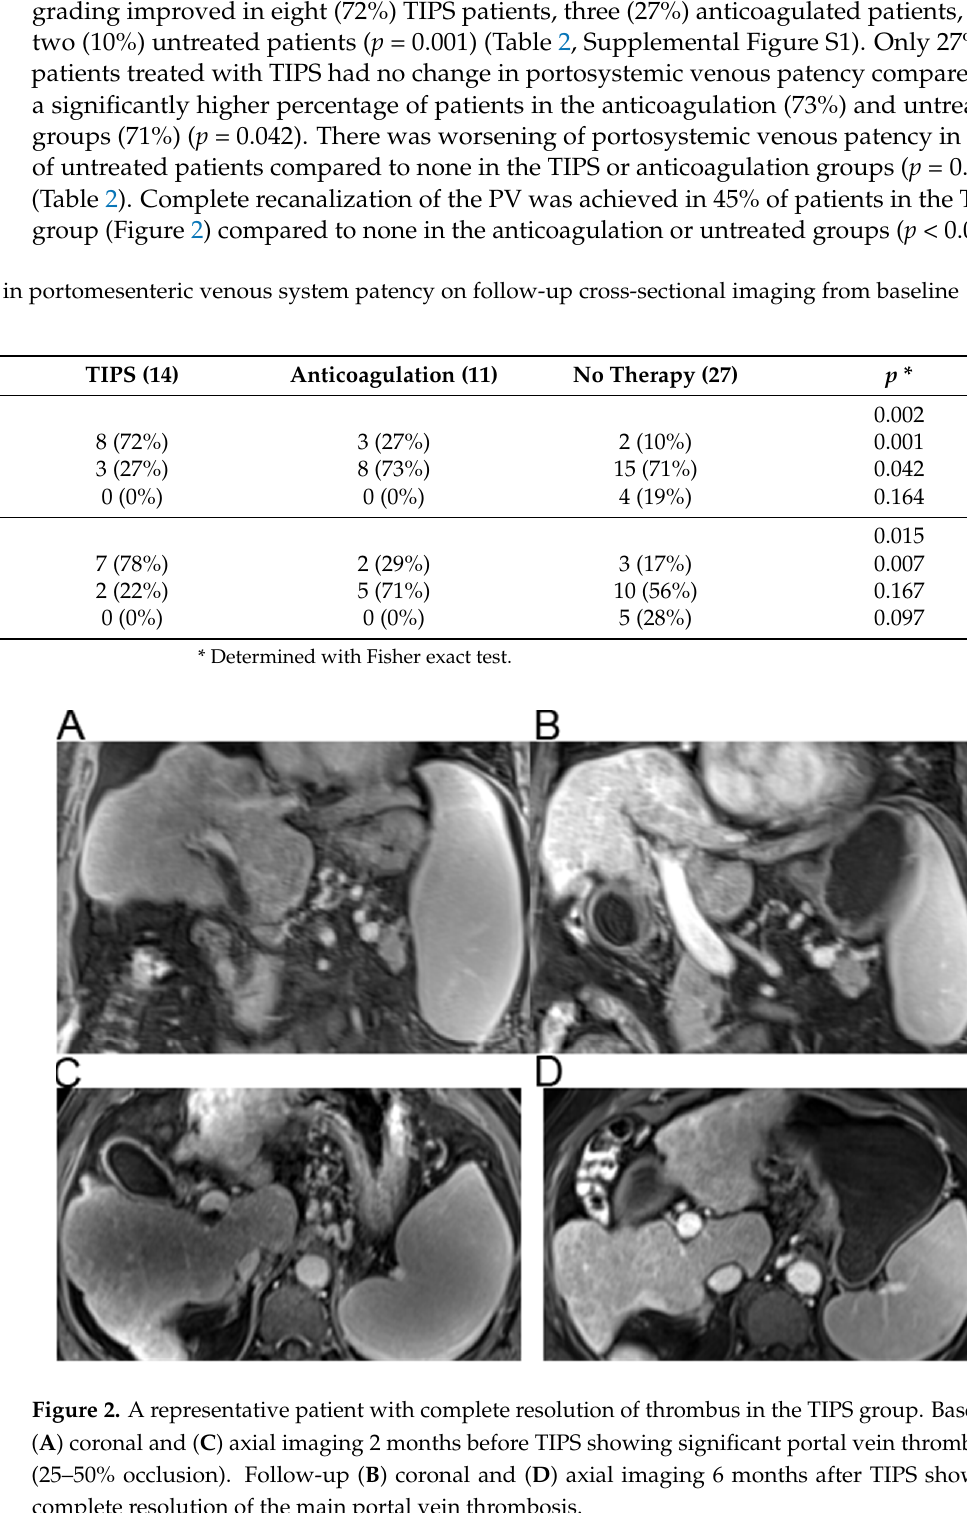
Table 2. Overall change in portomesenteric venous system patency on follow-up cross-sectional imaging from baseline using Yerdel grades.